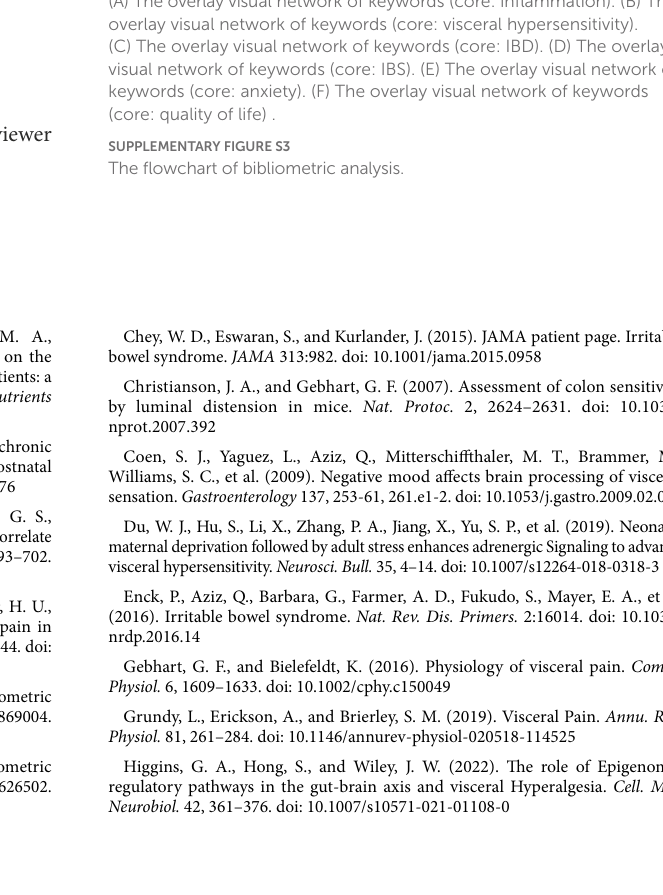
SUPPLEMENTARY FIGURE S1 The overlay visual network of keywords (The circle size represents the frequency of keywords, and different colors represent different time periods).